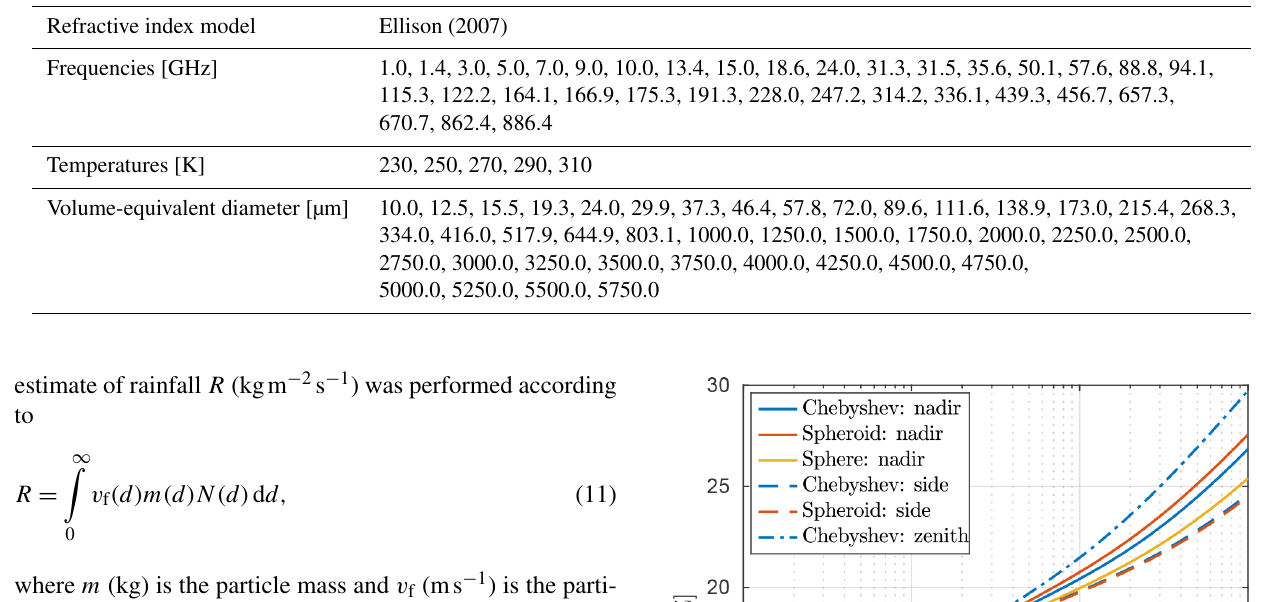
Table 1. Grid and details of the SSP calculations. Shapes